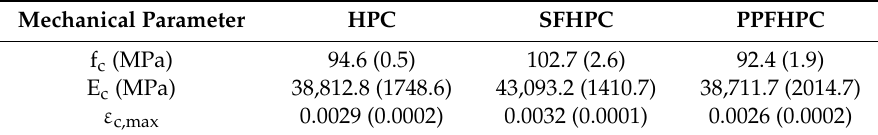
Table 3. Mechanical parameters of the concrete before starting the cyclic test. H-Series. Mechanical